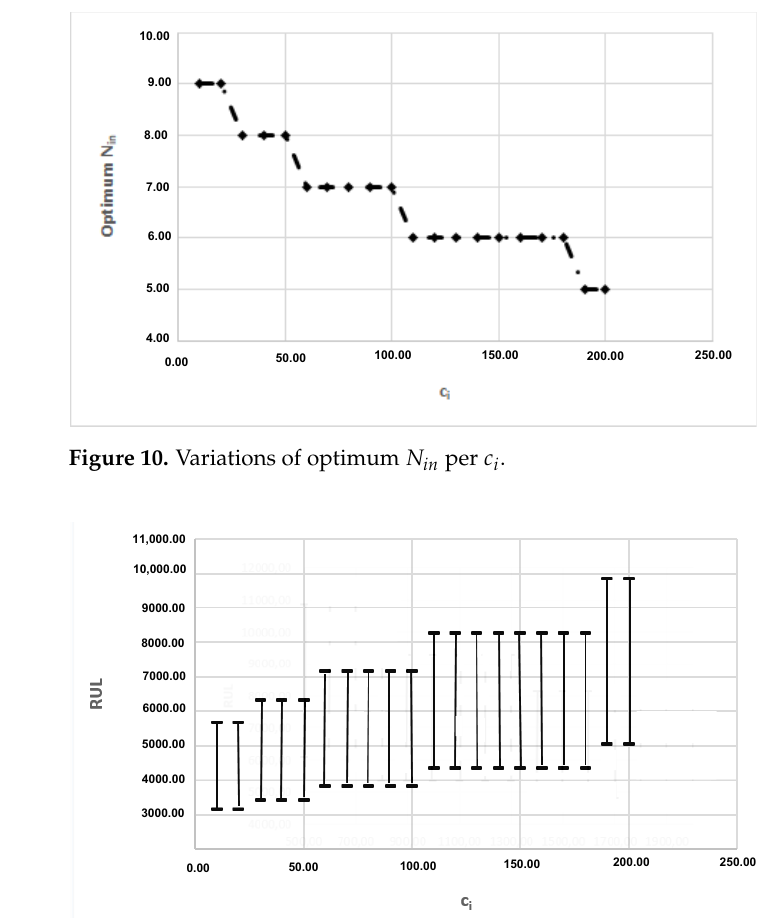
, RUL lim sup ] per c i inf